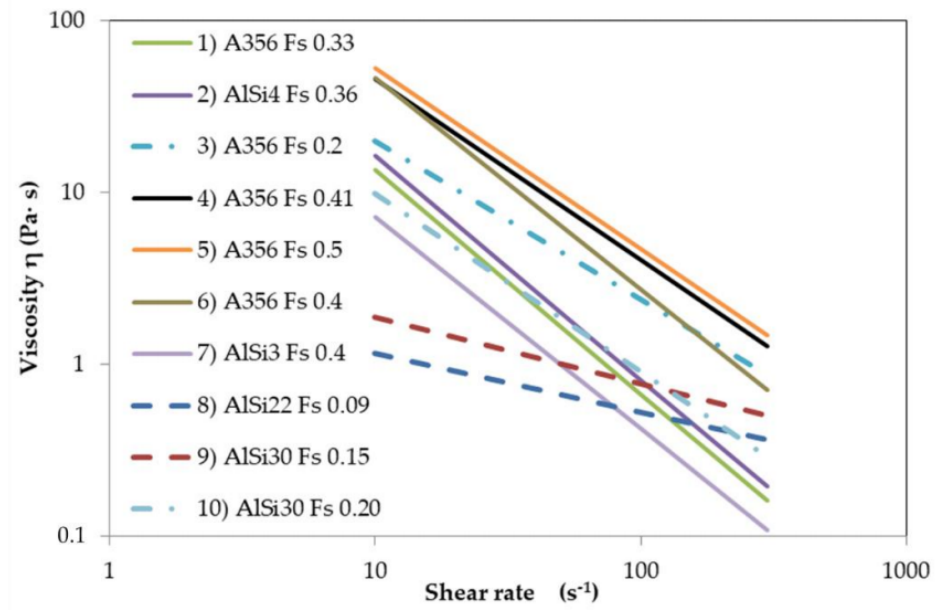
Figure 9. Comparison of flow curves according to parameters reported in the previous Table 1.